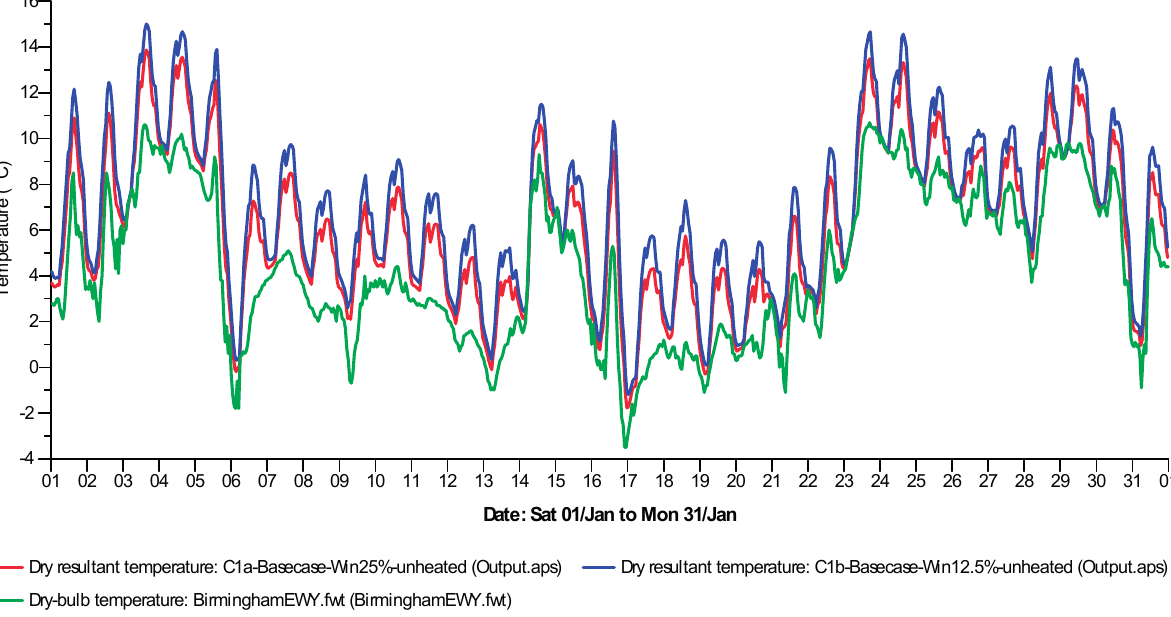
Figure 5. Predicted monthly (January) indoor temperature for unheated base cases.